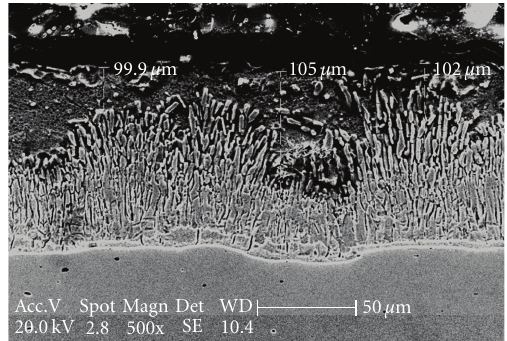
Figure 1: Scanning electron micrograph of the cross section of galvanized steel showing various Zn-Fe alloy layers and the thickness measurements.